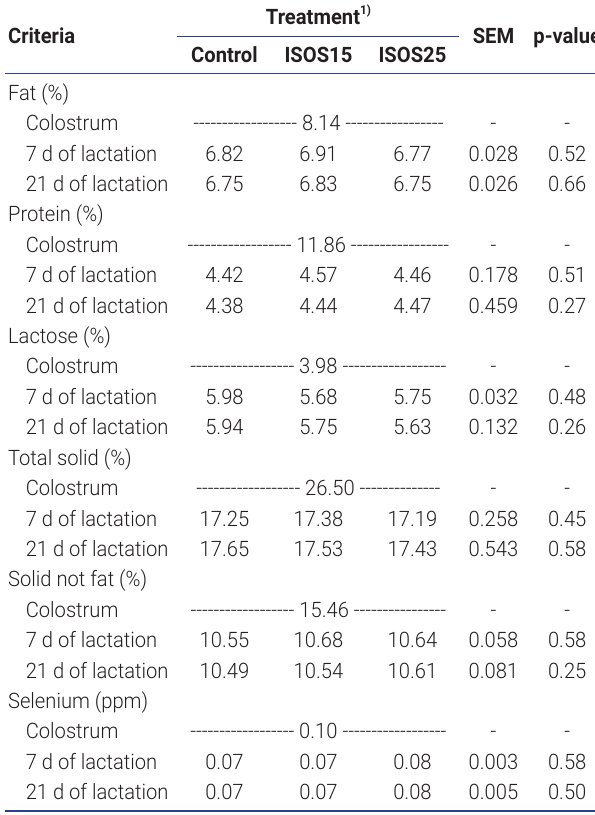
Table 4. Effects of supplemental selenium in the lactation diet on the milk composition of sows during lactation